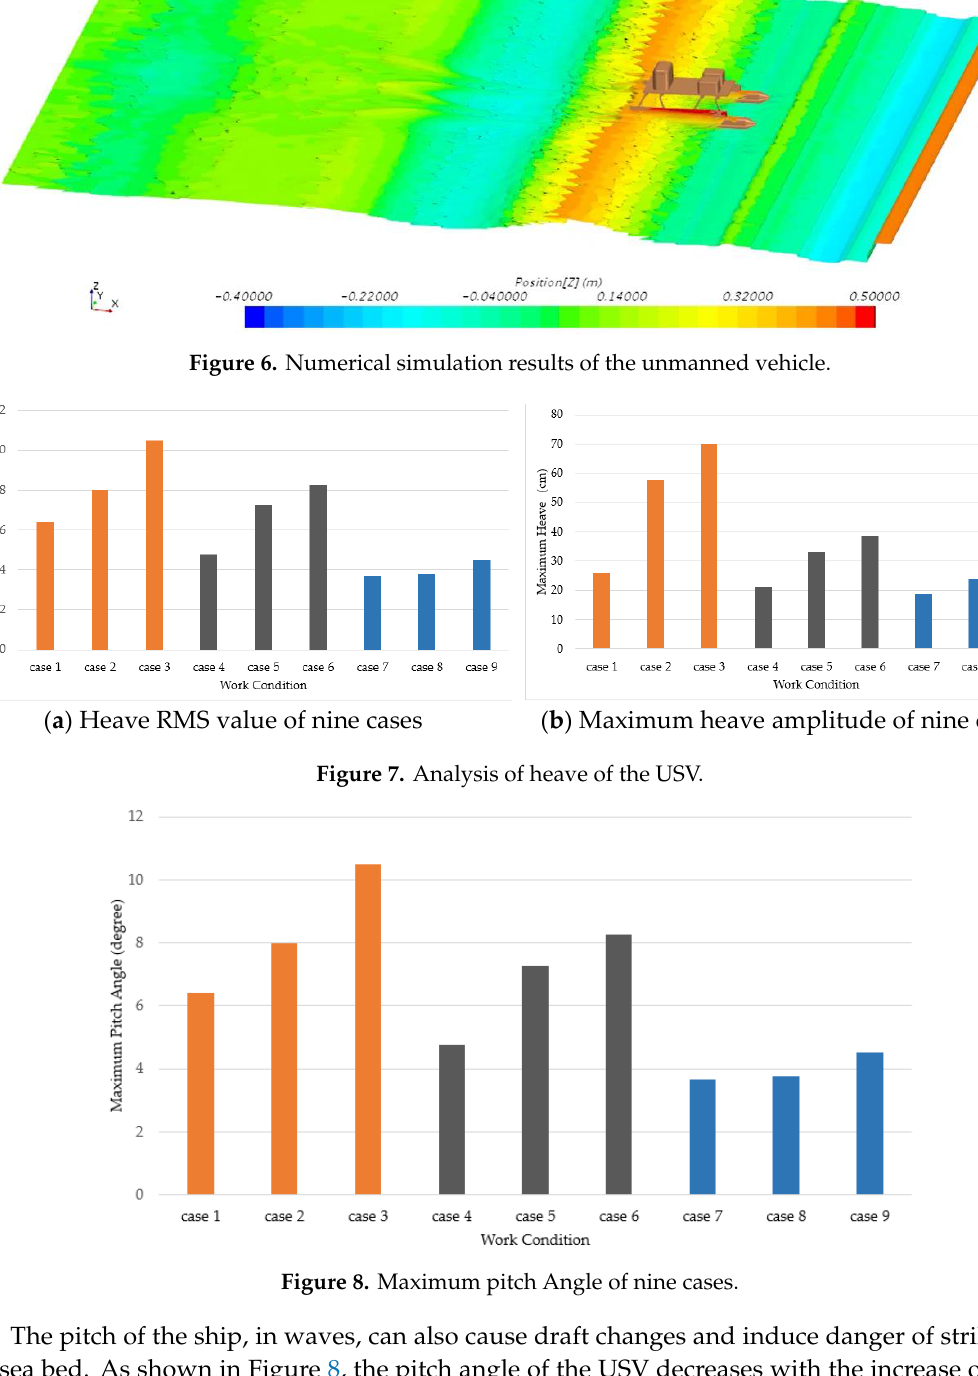
Figure 8. Maximum pitch Angle of nine cases.